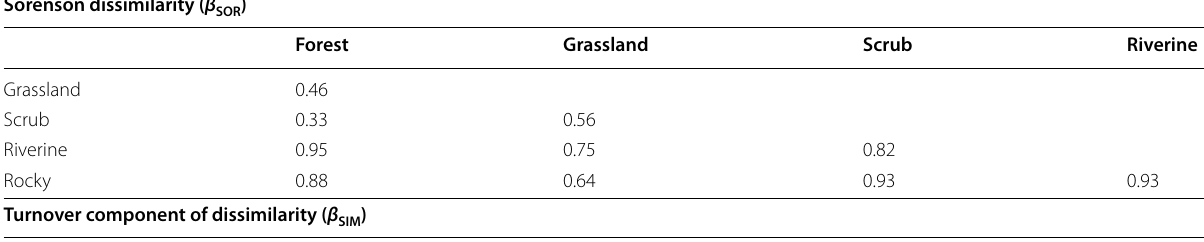
) and nestedness ( β SIM